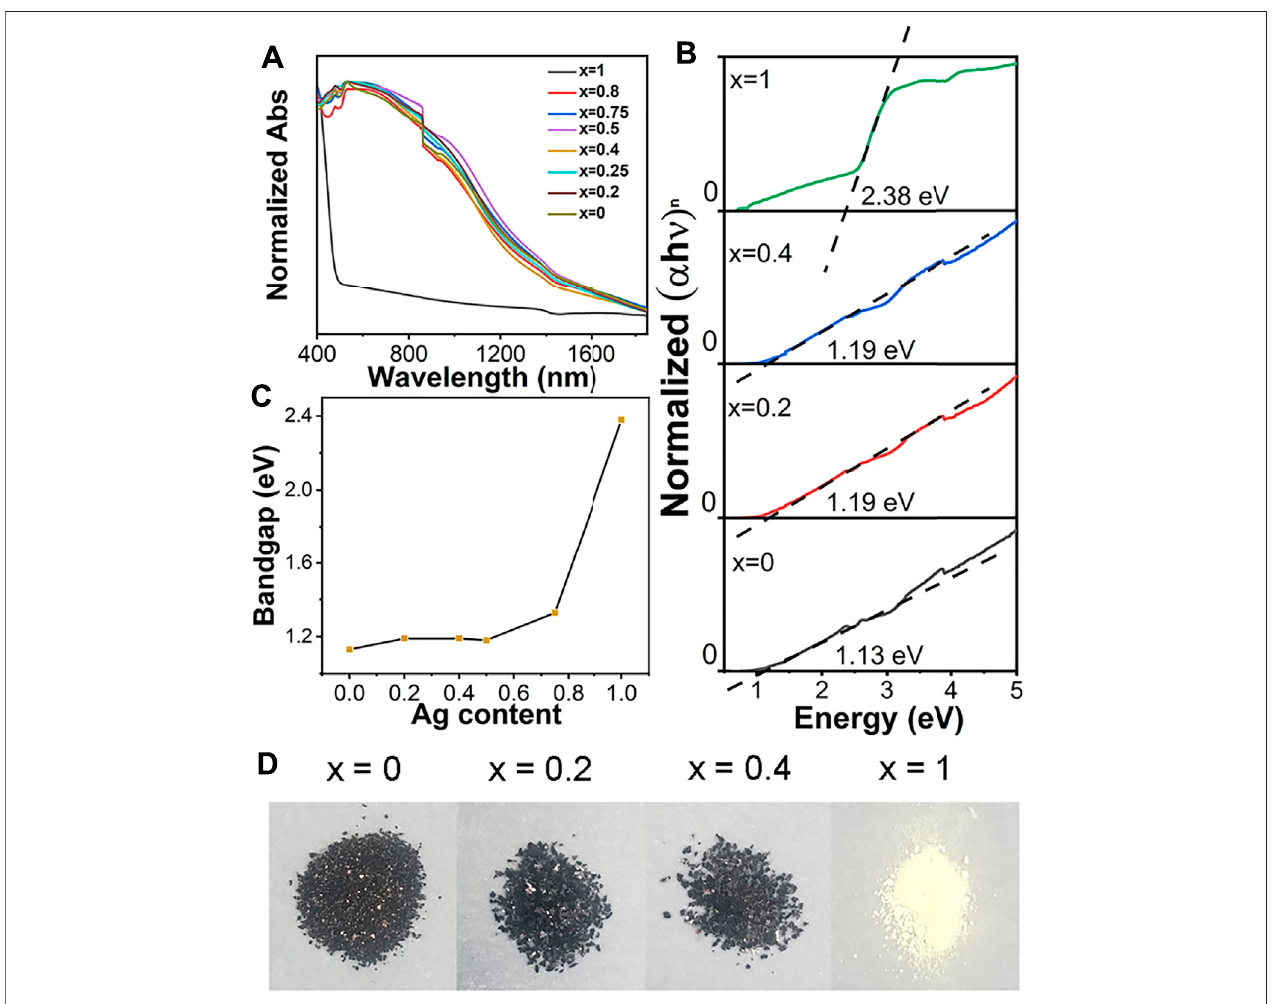
FIGURE2|(A) Steady-stateabsorptionspectraofCs 4 Cu 1-x Ag 2x Sb 2 Cl 12 (x=0,0.2,0.25,0.4,0.5,0.75,0.8,1)SCs. (B) TaucplotsofCs 4 Cu 1-x Ag 2x Sb 2 Cl 12 SCs. (x=1: n = 1 ;x=0,0.2,0.4: n =2) (C) CorrelationbetweenAgcontentandbandgapvalueofCs 4 Cu 1-x Ag 2x Sb 2 Cl 12 SCs. (D) PhotographsofCs 4 Cu 1-x Ag 2x Sb 2 Cl 12 (x=0, 2 0.2, 0.4, 1)